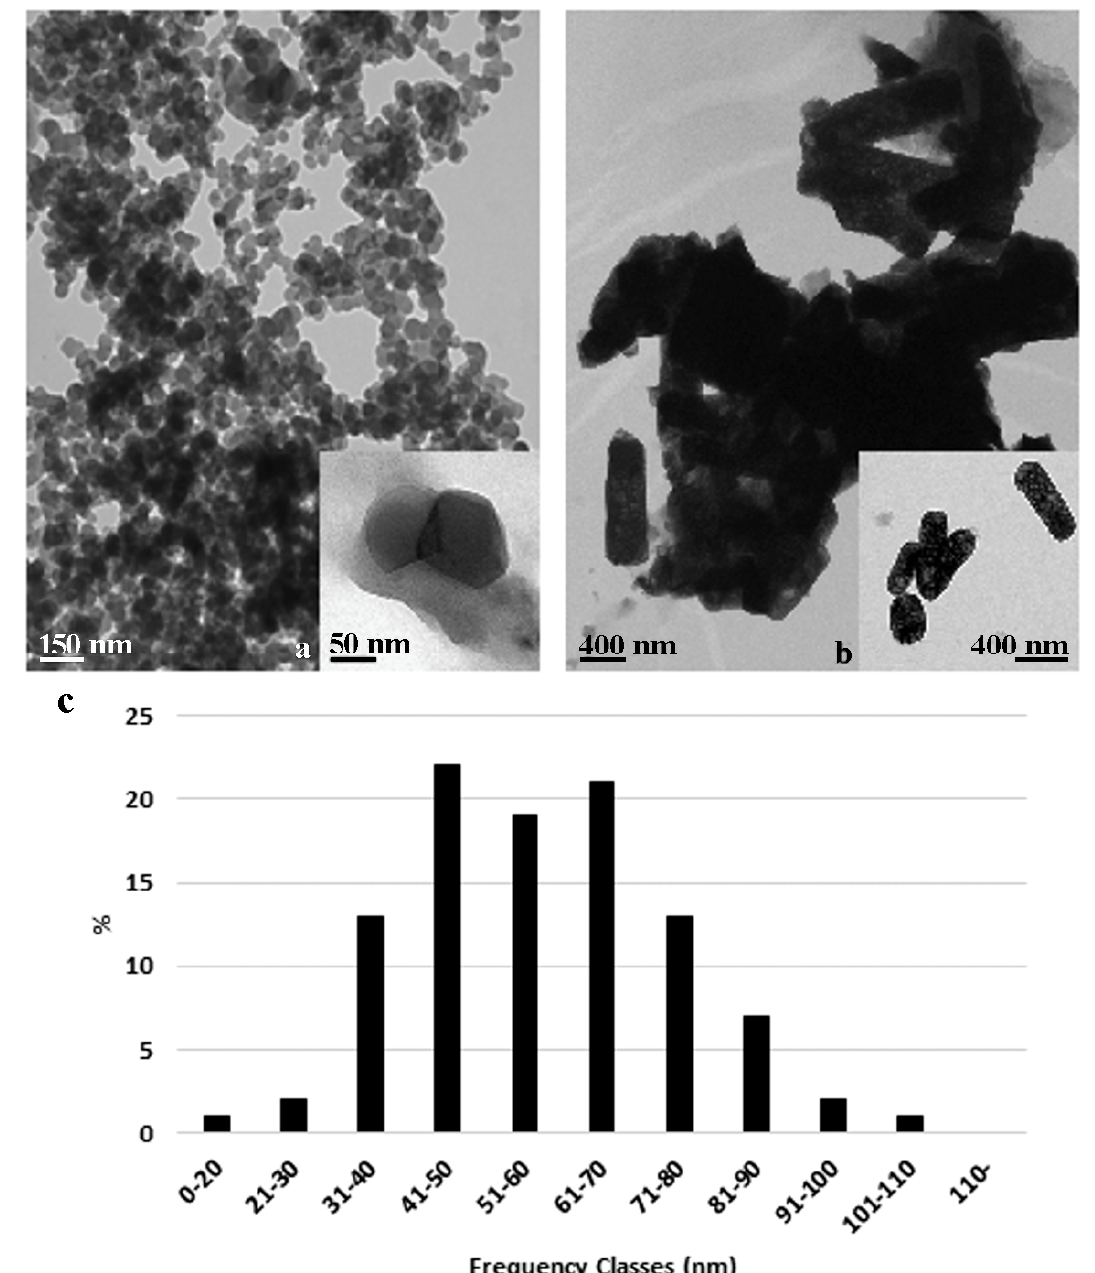
Figure 1. Transmission electron micrograph of the nanoparticle ( a ) and bulk form ( b ) of ZnO added in the root zone or as a leaf spray: size distribution of nanoparticles grouped in frequency classes ( c ) after an ImageJ program elaboration of TEM images.